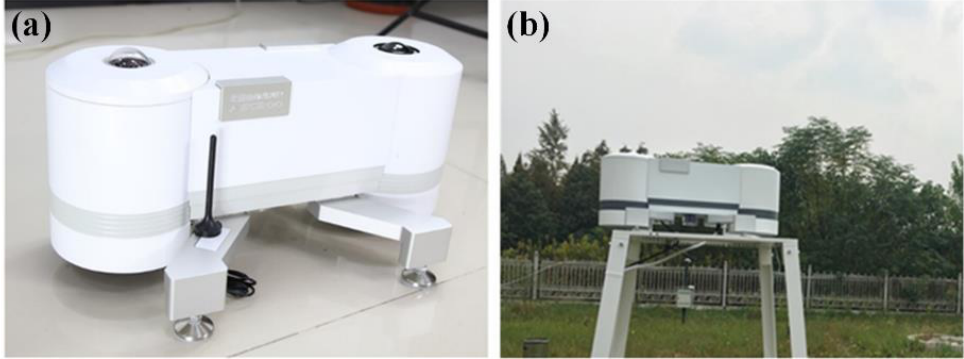
Figure 1. ( a ) All-sky camera 200 (ASC-200) and ( b ) ASC-200 in the meteorological observation Figure 1. (a) All-sky camera 200 (ASC-200) and (b) ASC-200 in the meteorological observation sta- tion.